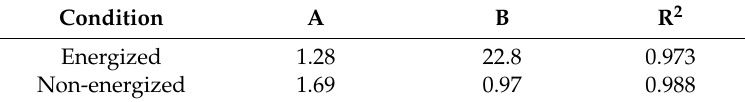
Table 4. Value of A, B and R 2 under different electric field condition.